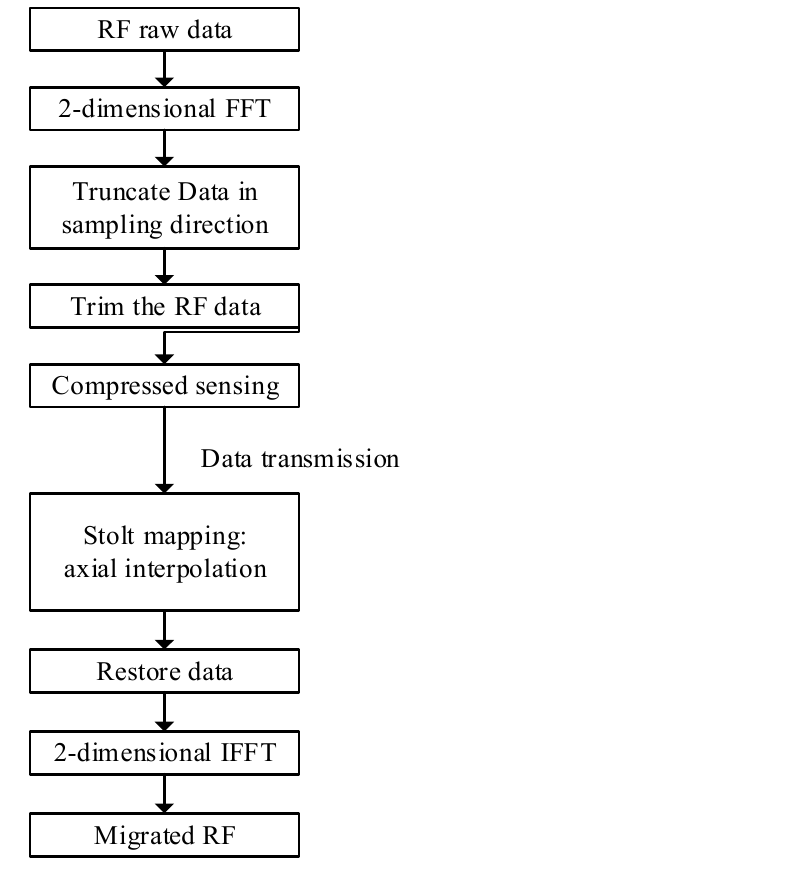
Figure 4. Diagram of wavenumber domain compressive beamforming.